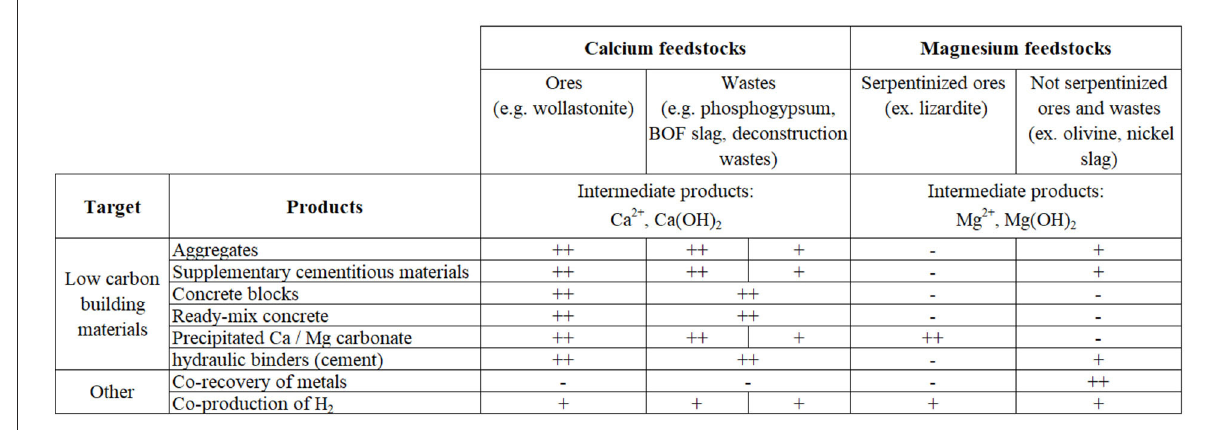
FIGURE1 Overview of ex-situ mineral carbonation developments ( ++ High maturity/commercial developments, + Significant research and development, - largely